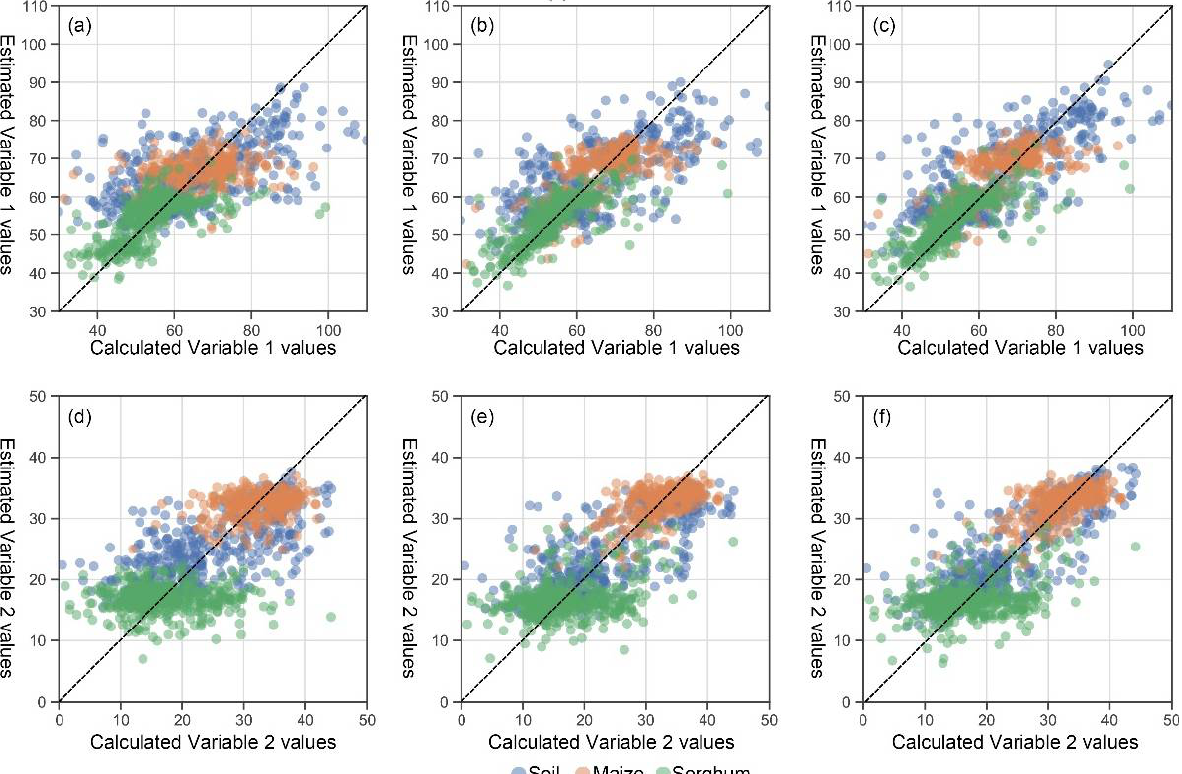
Figure 8. Scatters between calculated and estimated soil Variable 1 (fertility indicator) using: ( a ) UAV; ( b ) Sentinel-2B; and ( c ) the integration of UAV and Sentinel-2B data. Scatters between calculated and estimated soil Variable 2 (salinity and sodicity indicator) using: ( d ) UAV; ( e ) Sentinel-2B; and ( f ) the integration of UAV and Sentinel-2B data.